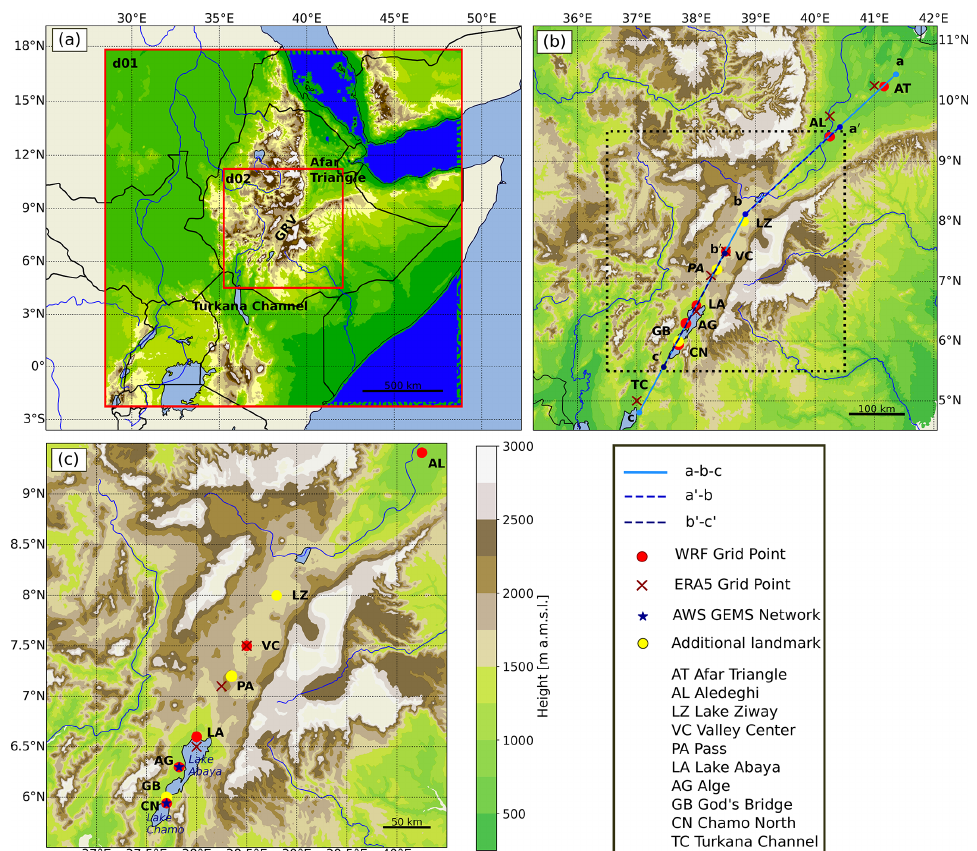
Figure 1. (a) Topographic map of East Africa with the two nested Weather Research and Forecasting (WRF) model domains d01 and d02 indicated by the red boxes. The area contains the Afar Triangle, the Turkana Channel, and the Great Rift Valley (GRV) in between. (b) Topographic map of d02 and the GRV. Along-valley cross-sections marked in blue (a–b–c, a (cid:48) –b, and b (cid:48) –c (cid:48) ). Several grid points of the WRF model (red circles) and the ERA5 reanalysis (dark-red crosses) used in the investigations are indicated by markers and two-letter labels (see legend). (c) Topographic map of the target area around Lake Abaya and Lake Chamo. This subdomain is also indicated by a dashed black box in (b) . Blue stars indicate the location of automatic weather stations of the Gamo Ethiopian Meteorological Stations (GEMS) network. Yellow circles mark additional